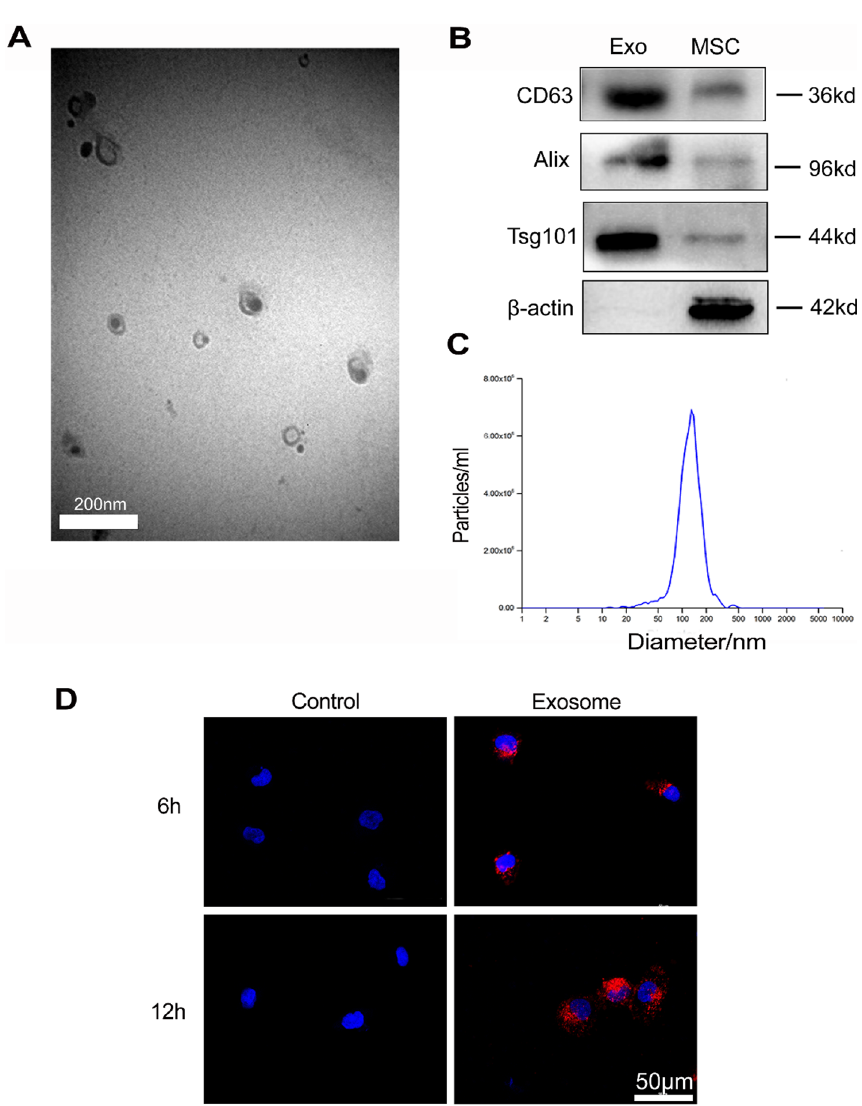
Fig. 1 Identification and labeling of HucMSC-Exo. A Morphology of HucMSC-Exo detected by electron microscopy. B Western blot detection of exosome-related markers in HucMSC-Exo and MSC. C HucMSC-Exo nanoparticle size analysis detected by Particle Metrix’ ZetaView; particles were mainly enriched at 128.7 nm. D HK-2 cell uptake of HucMSC-Exo labeled by